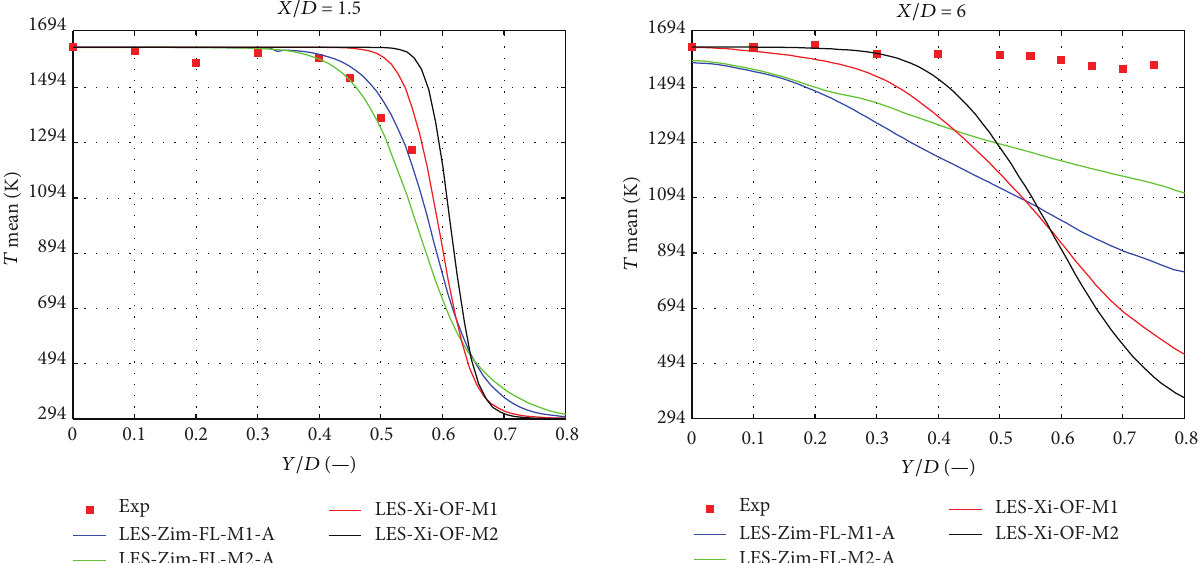
Figure 14: Mean temperature profiles with OpenFOAM and Fluent (LES).